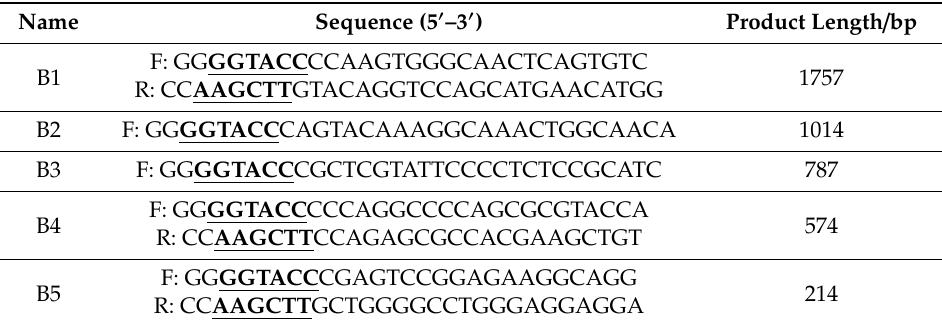
Table 1. Primers for deletion plasmids construction from the Hu sheep BMP7